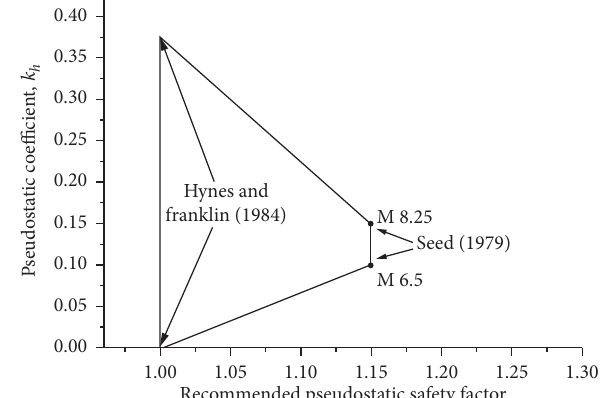
Figure 2: Seismic stability charts for rock slopes using the limit analysis method [22]. (a) β � 45 ° , k 0.3.